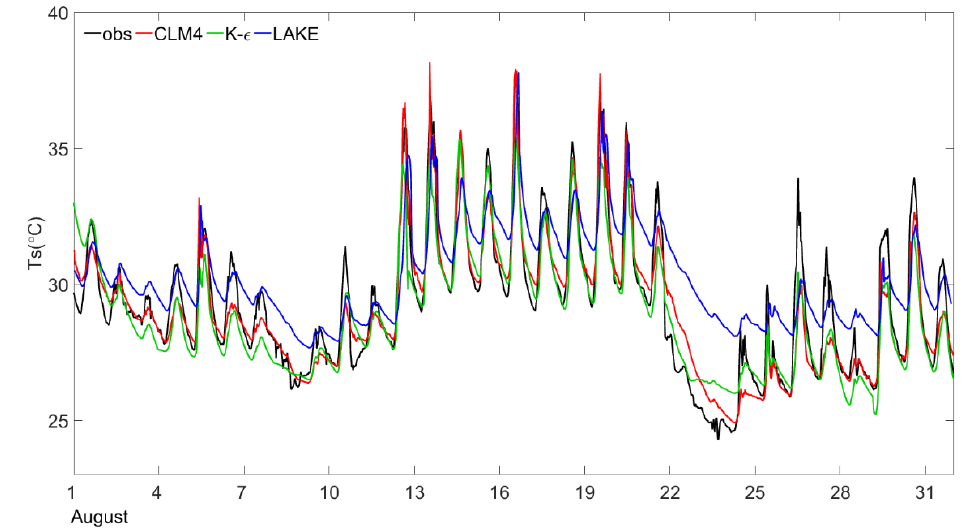
Figure 2. Weather conditions at BFG Station in Lake Taihu in August 2012. ( a ) is 2m air temperature, ( b ) is downward solar radiation and ( c ) is 10m wind speed.